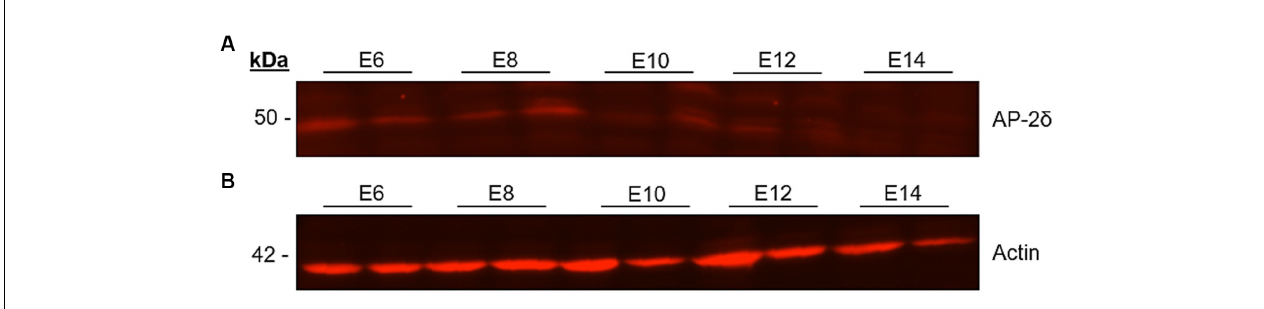
FIGURE 2 | Western blot analysis of AP-2 δ . Midbrains of E6–E14 chicken embryos were lysed with RIPA buffer and proteins were separated in a 10% SDS-PAGE gel and transferred to a nitrocellulose membrane. The gel was loaded with lysate. (A) To detect the AP-2 δ (50 kDa), a rabbit anti-AP-2 δ antibody and an Alexa Fluor TM 546 goat anti rabbit IgG (H + L) secondary antibody were used. (B) Loading control with rabbit anti- ε -Actin antibody (42